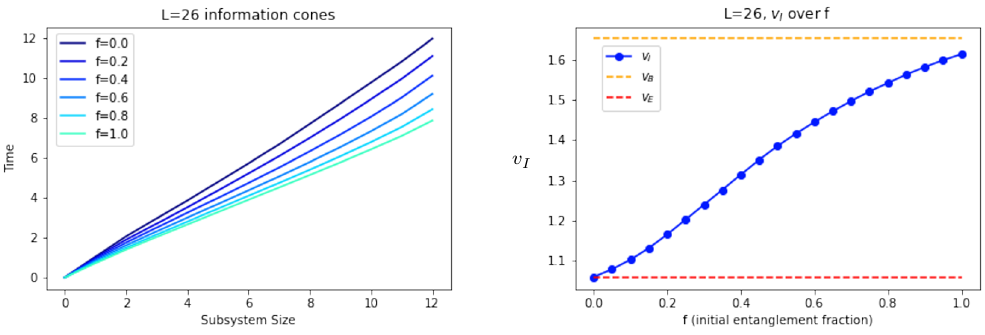
Figure 1 . Left: a sample of information cones in the H (0) system for various values of initial L =26 entanglement fraction f . Right: information velocity as a function of f , extracted from the curves in the left panel. The dotted lines represent the butterfly velocity v B , as obtained through an independent OTOC computation, and the entanglement velocity v E , computed as the linear growth rate of entanglement on half the